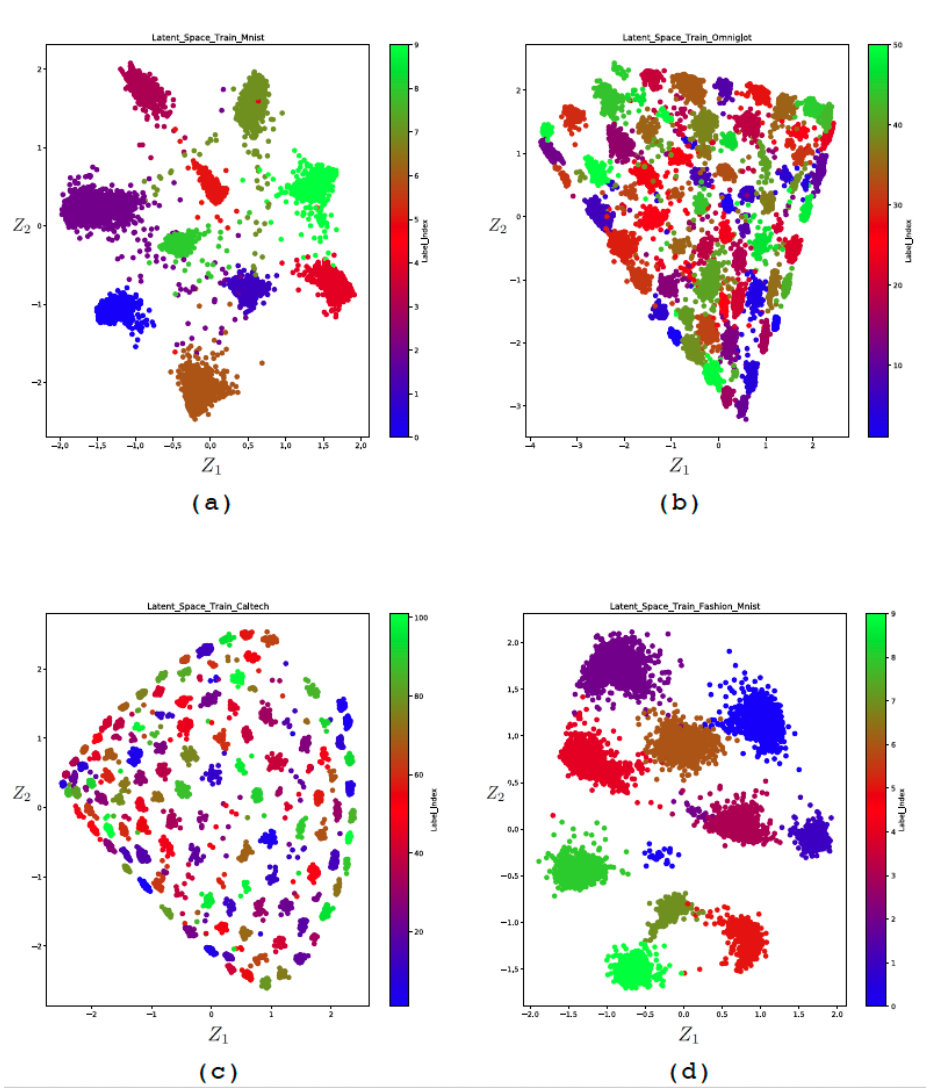
Figure 7. The 2D latent space obtained for the four databases; ( a ) MNIST, ( b ) Omniglot, ( c ) Caltech 101 Silhouettes, ( d ) Fashion